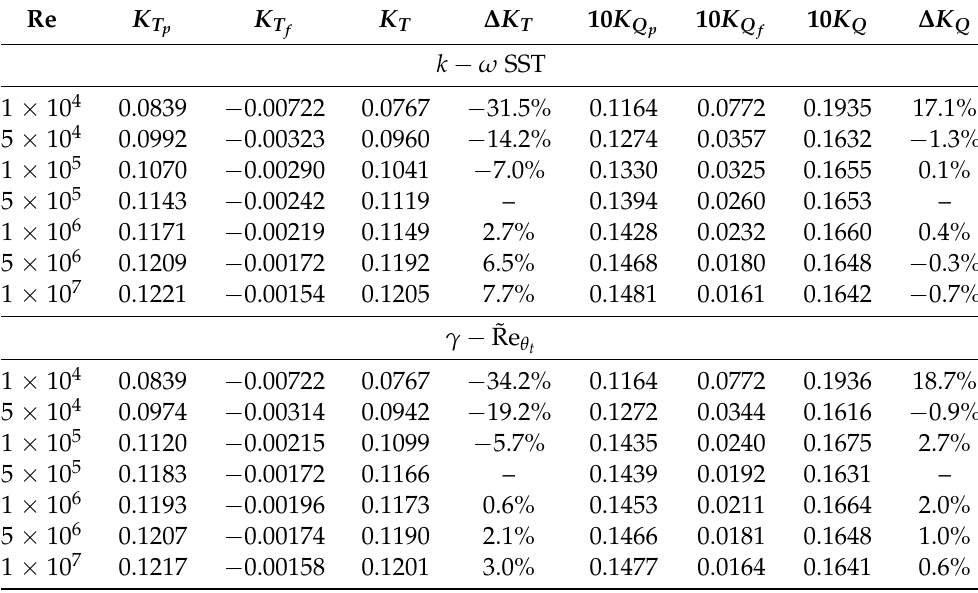
Table 8. Pressure ( p ) and friction ( f ) contributions to the propeller thrust and torque coefficients at J = 0.568. Prediction of the scale-effects on K T compared to Re = 5 × 10 5 .